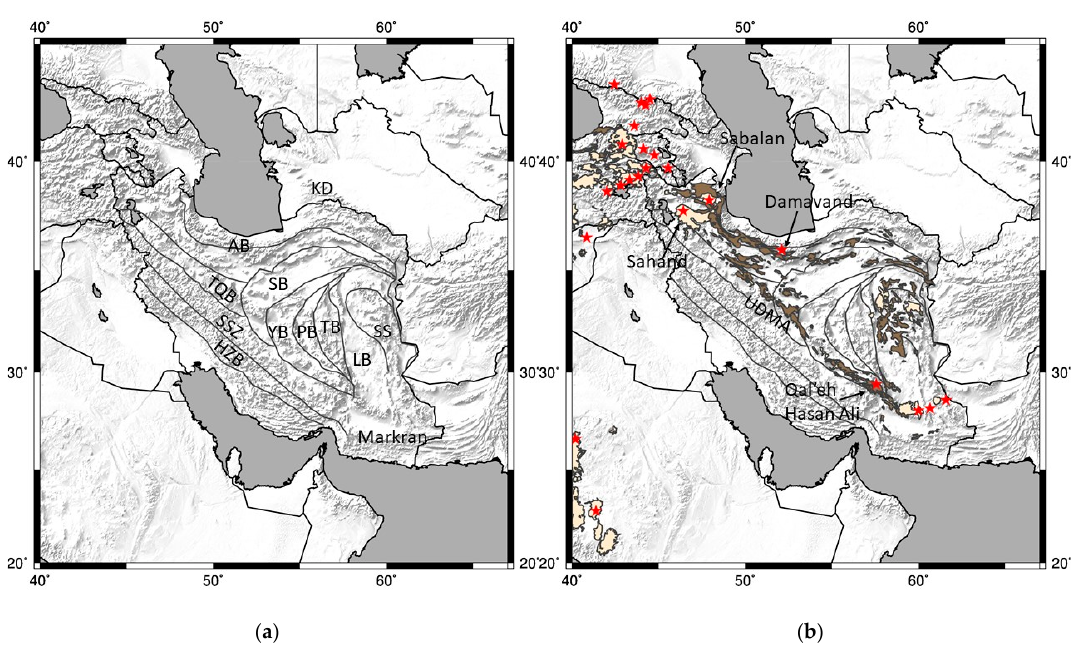
Figure 1. ( a ) Tectonic map of Iran with major blocks noted. The main plate boundary lies between the High Zagros Block and the Sanandaj-Sirjan Zone. ( b ) Red outlines are Neogene volcanics and tan outlines are Paleogene volcanics. Red stars are Holocene volcanoes. Faults from Arefifard [35]; volcanoes and volcanic outlines from Seber et al. [36]. AB—Alborz Belt; HZB—High Zagros